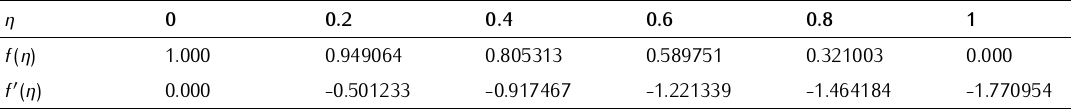
Table 1. The obtained values in accordance with the numerical solution.